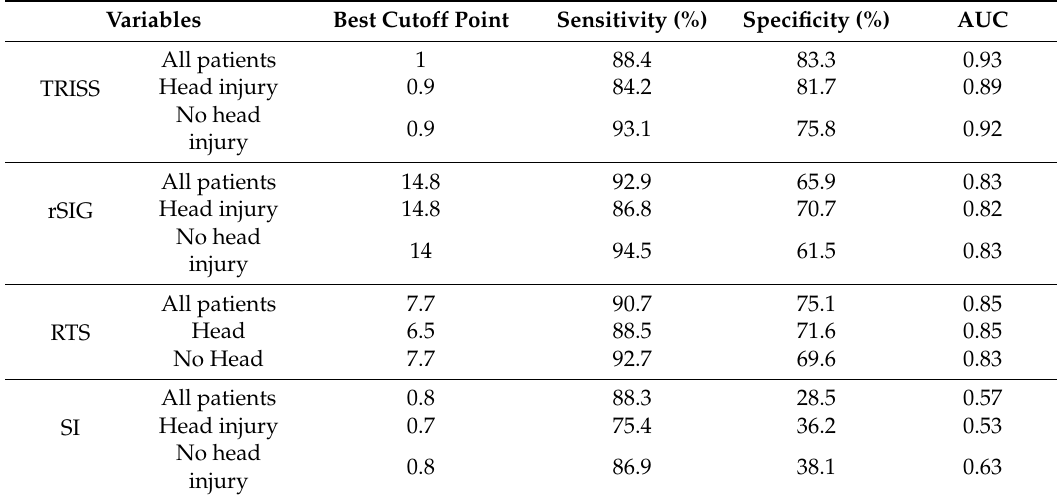
Table 4. The best cutoff point with its sensitivity and specificity that could predict the risk of mortality among the trauma